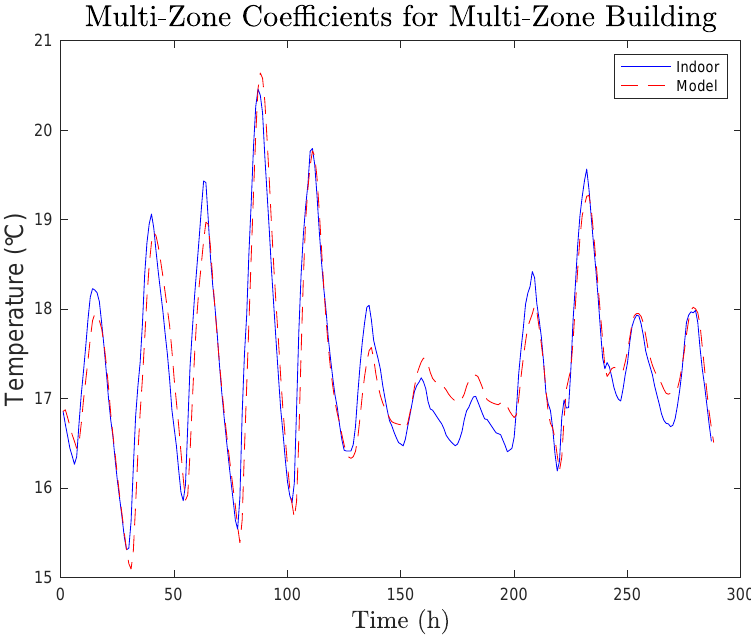
Figure 9. Second order model for indoor air temperature of a multi-zone building.